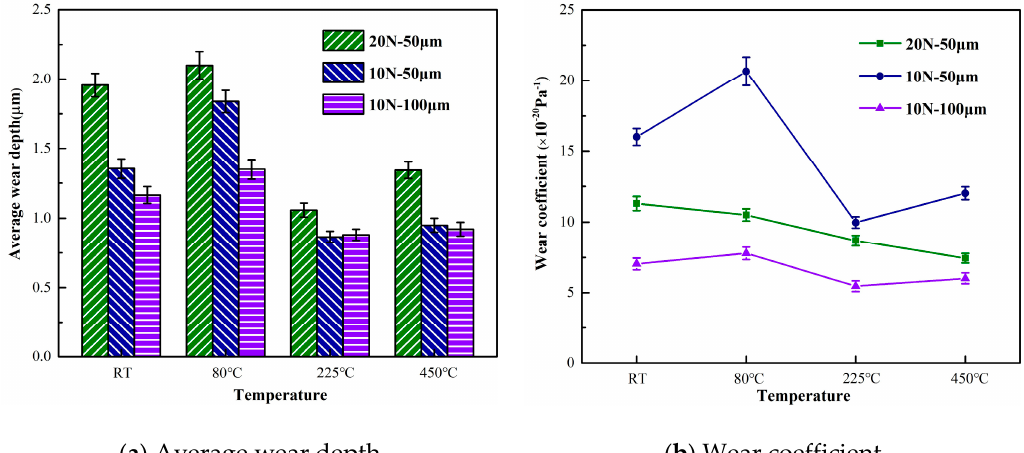
Figure 7. Average wear depth and wear coefficient of 2.25 Cr-1Mo steel.